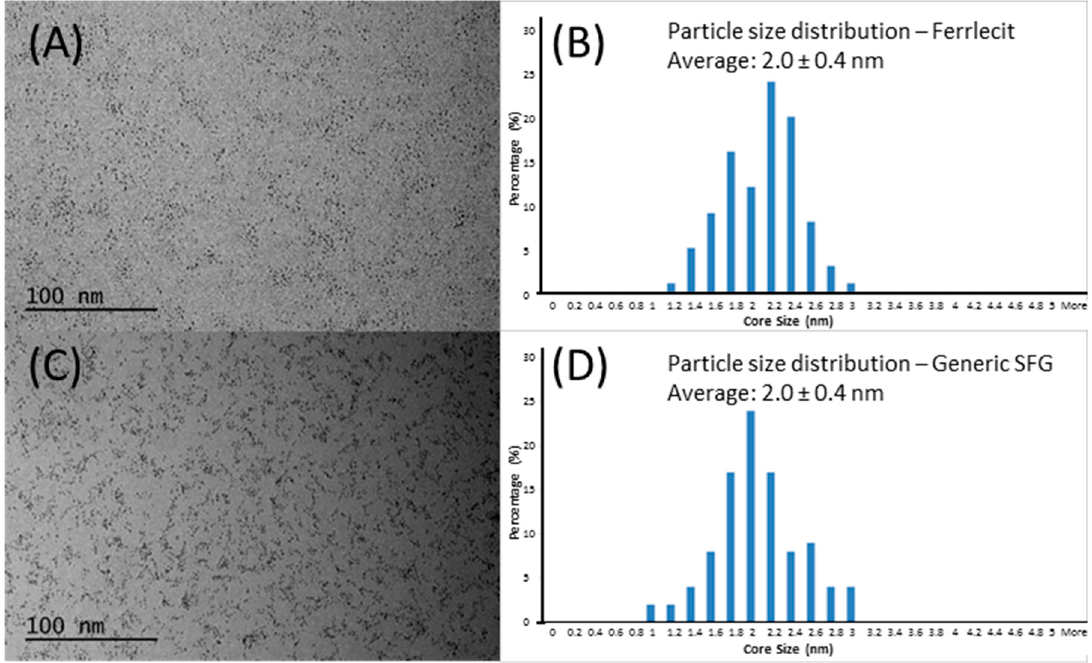
Figure 2. Cryogenic transmission electron microscopy (cryo-TEM) images and size distribution of Ferrlecit lots of D2C283A and D2C593A ( A , B ) and generic SFG lot of 132296.1 ( C , D ).